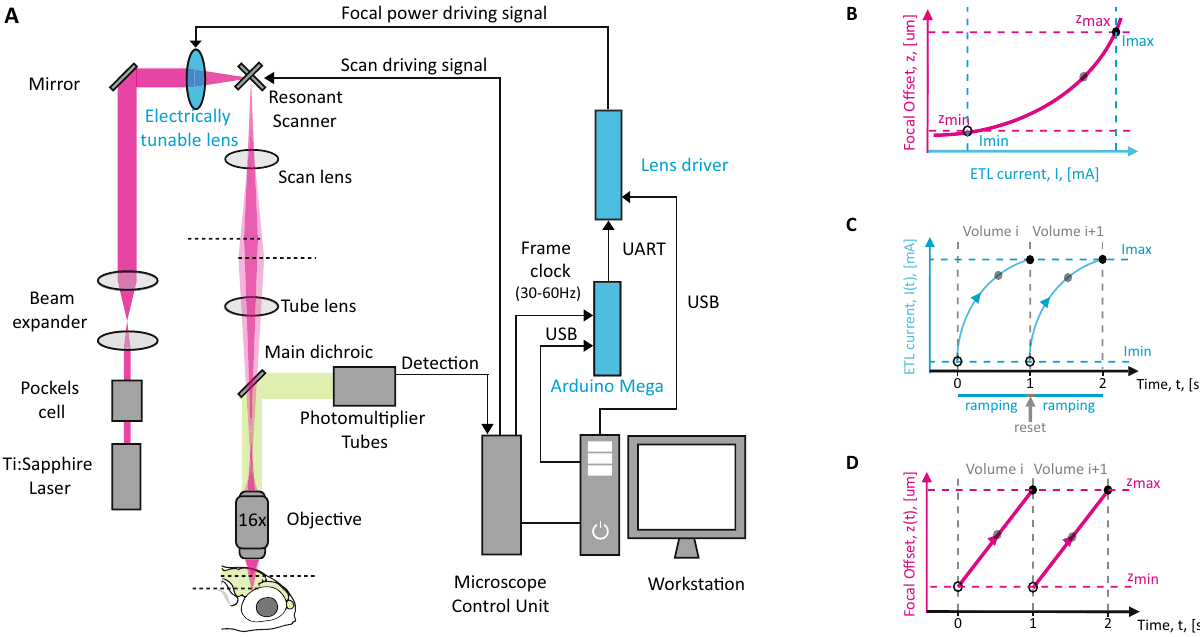
Figure 1. The layout of the optical configuration and the properties of the ETL. ( A ) Implementation of the electrically tunable lens along the optical path, the lens driver and the microcontroller (blue components). The image was generated using Adobe Illustrator CS2 (https:// adobe. com/ produ cts/ illus trator). ( B ) The ETL Look- Up-Table (LUT). Relationship between the input current to the ETL (blue axis) and the change in the focus resulting at the level of the sample (magenta axis). ( C ) The ETL input current works in a quasi-sawtooth pattern. The pattern is composed of two phases. A ramping one, where the input current to the ETL is continuously increased according to the LUT; and a reset one, where the input current is reset to 0 mA. The cycle occurs every 30 frames. ( D ) At the level of the sample, this pattern is translated in a continuous and linear change of the